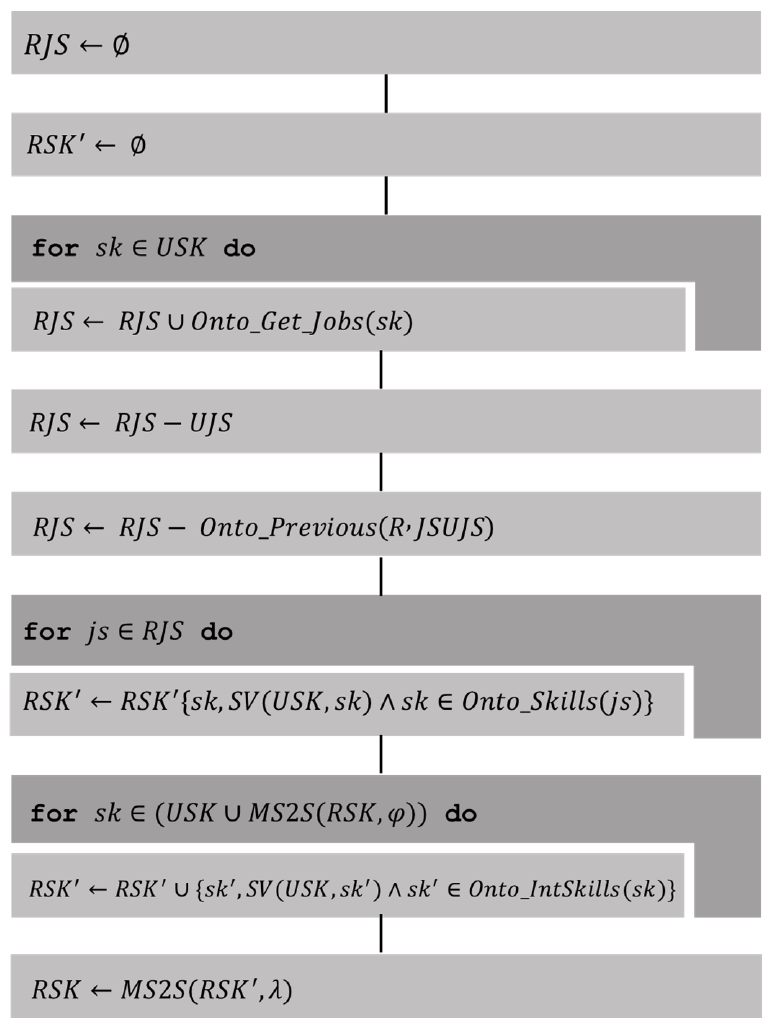
Figure 4. Related Job Sectors algorithm.